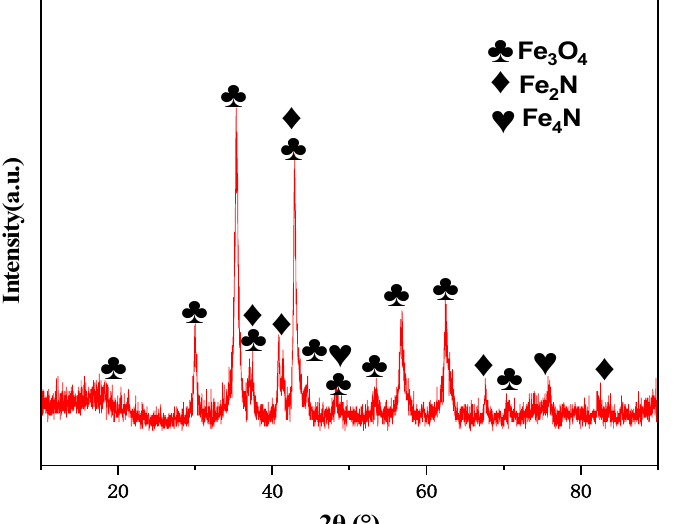
Figure 5. Nitriding surface XRD.